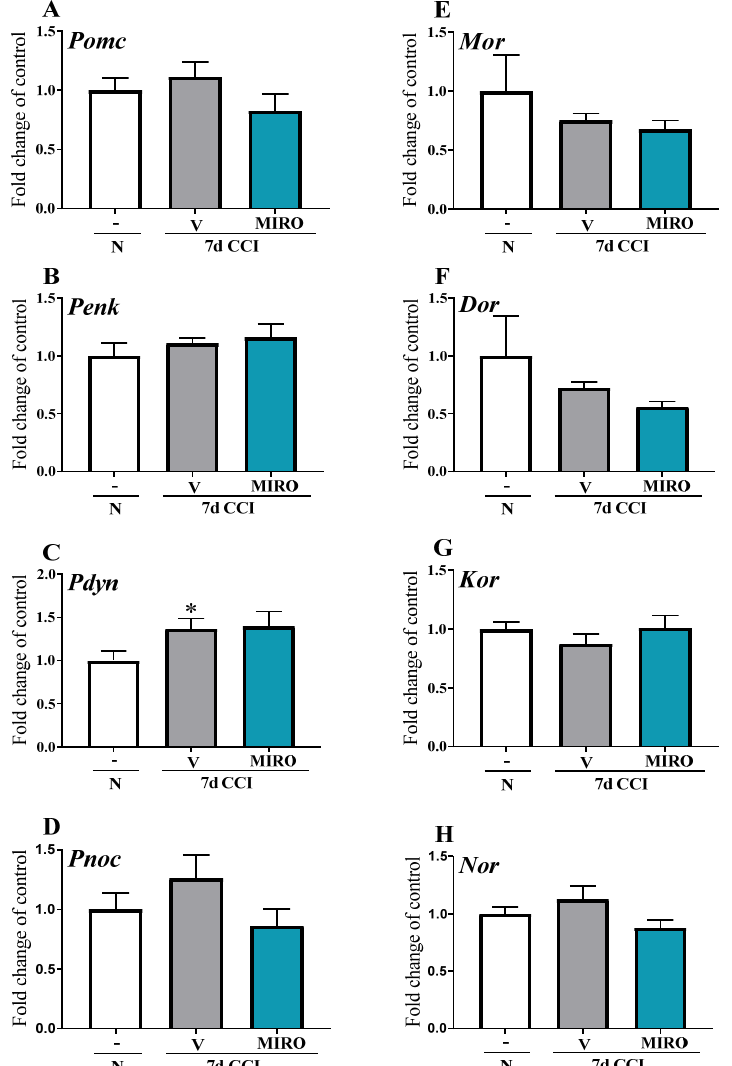
Figure 7. Effect of repeated intraperitoneal ( i.p. ) administration of mirogabalin (MIRO; 20 mg/kg) on the Pomc ( A ), Penk ( B ), Pdyn ( C ), Pnoc ( D ) and Mor ( E ), Dor ( F ), Kor ( G ), Nor ( H ) mRNA levels in the spinal cord on day 7 post-CCI in mice. The data for biochemical studies were analysed as fold changes compared with the controls and represent normalized averages derived from the RT–qPCR threshold cycles of 5–11 samples from each group. Intergroup differences were analysed based on one-way ANOVA with Bonferroni’s multiple comparisons post hoc test. * p < 0.05 indicates a significant difference compared with the naïve group. Abbreviations: N—naïve, V—vehicle; MIRO—mirogabalin.